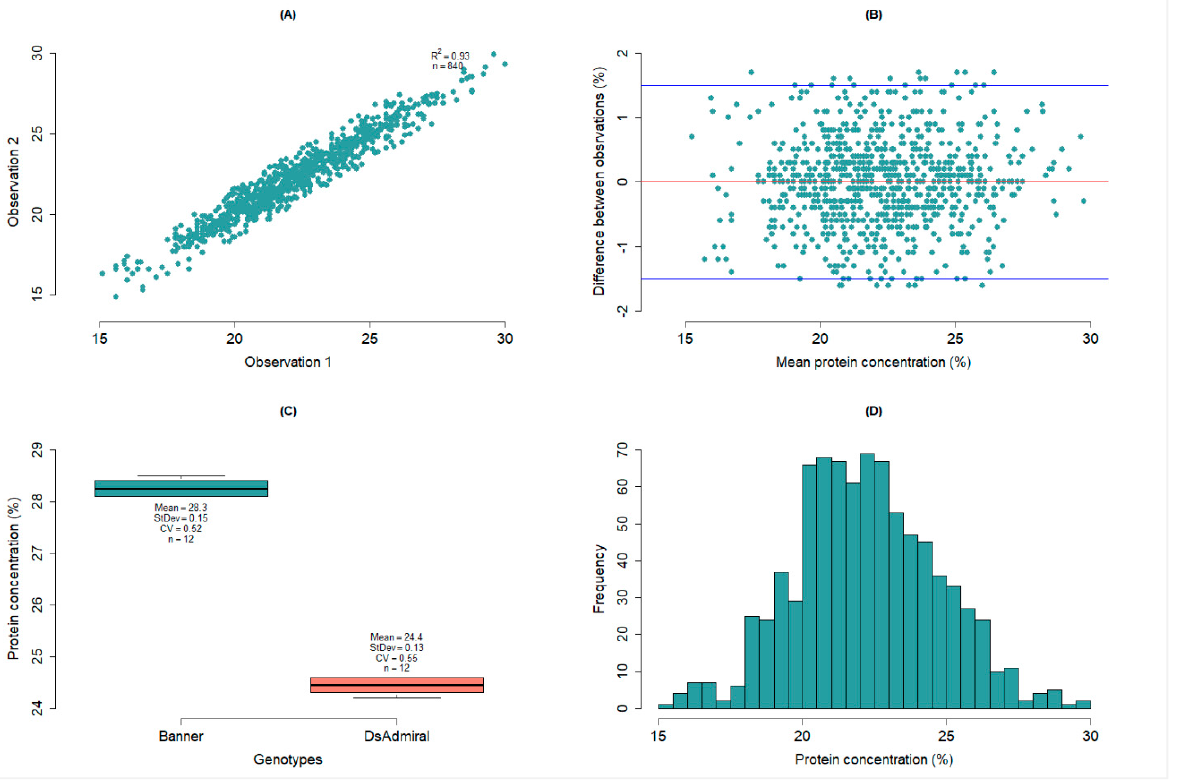
Figure 1. Diagnostic plots of reference data: ( A ) scatter plots of protein concentration observation 1 against observation 2, ( B ) plot of the differences between pair of observations against mean of each entry, ( C ) boxplots of multiple measurements (n = 12) of protein concentration for two pea genotypes (Banner and Ds Admiral) sampled from yield trial conducted at Fairfield, WA in 2020, and ( D ) distribution of protein concentration for the entries. Table 2. Minimum, mean, and maximum protein concentration (%) for flour and EDTA, flour ash concentration (%), and moisture content